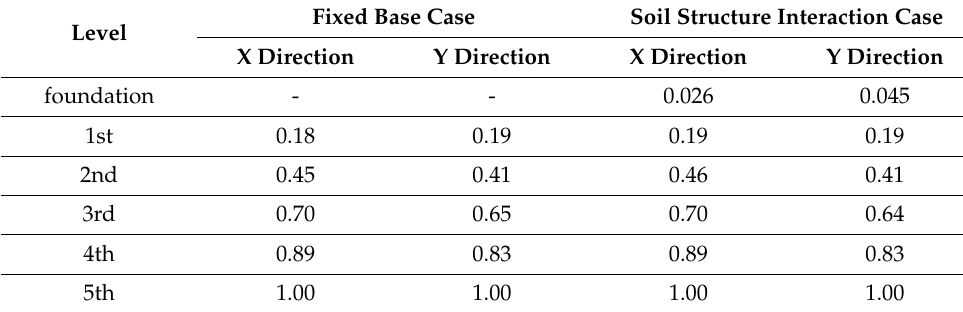
Figure 11. Vertical distribution of lateral forces for pushover analysis. Table 9. Normalized values of lateral pushover forces.